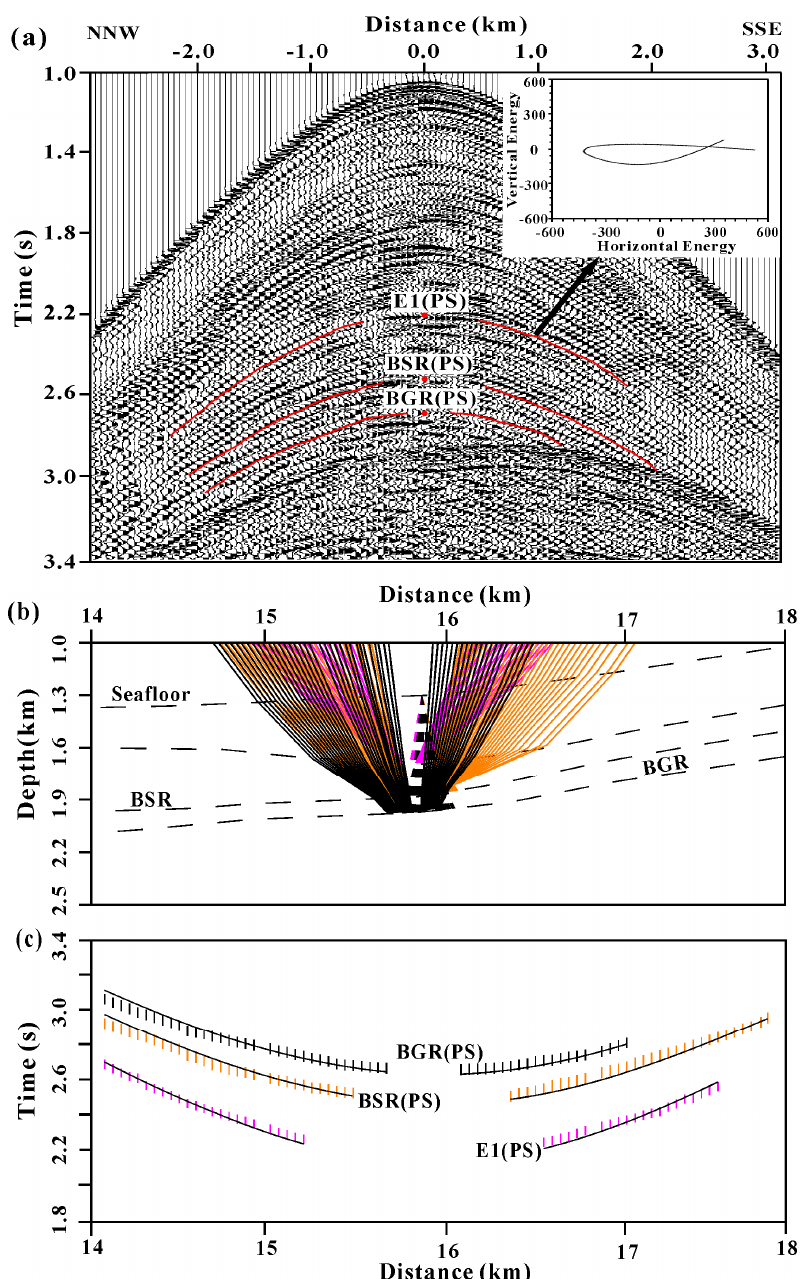
Figure 5. ( a ) Inline component of OBS 7 showing travel time picks (red lines) of PS-waves. The horizontal axis is the distance between projected OBS position and shot position. The travel times at minimum offset corresponding to the PS-waves are indicated with the red dots. The inset shows the particle motion plot for the E1 (PS) event; ( b ) PS-wave ray diagram modeled on OBS 7; ( c ) the fit between calculated (solid lines) and observed (short vertical lines) travel times. The colors of observed travel times are the same as those of corresponding rays in panel ( b ).